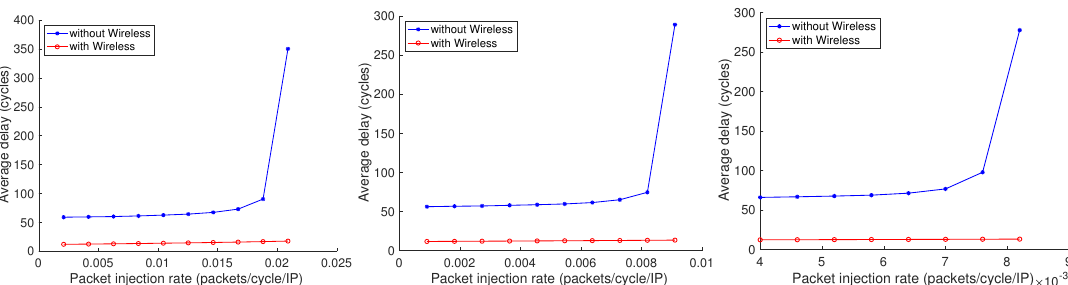
Figure 16. Average delay for profiles T 16 , T 32 , and T 64 1024 Mesh topology and table-based traffic (TT-1024